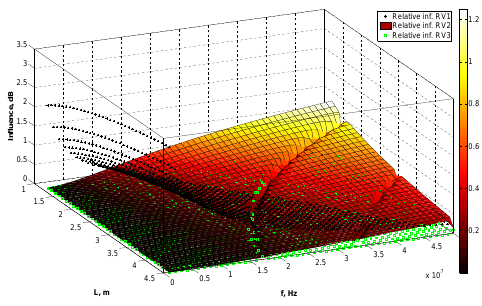
Figure 15: Influence criterion In 3